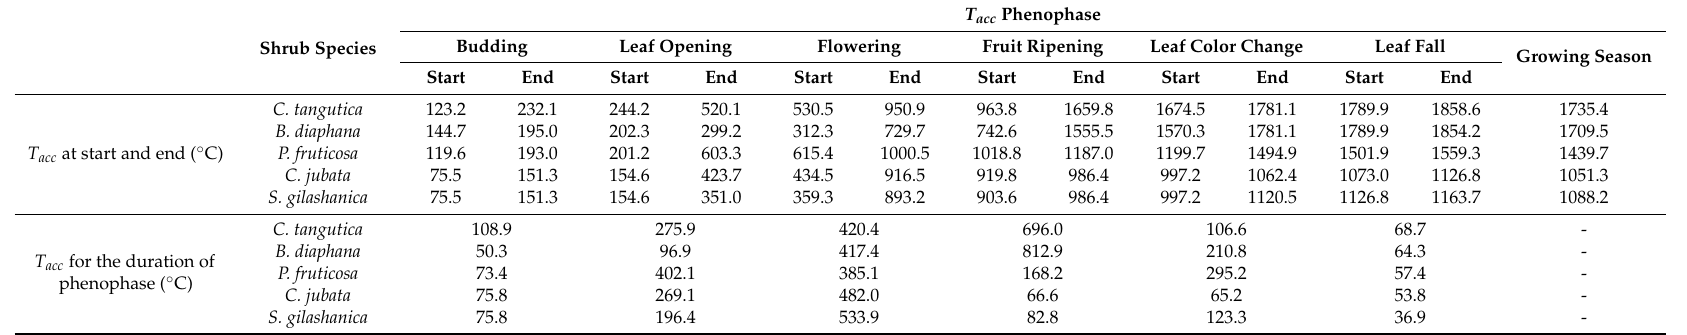
Table 4. T acc of individual phenophases and their duration for each